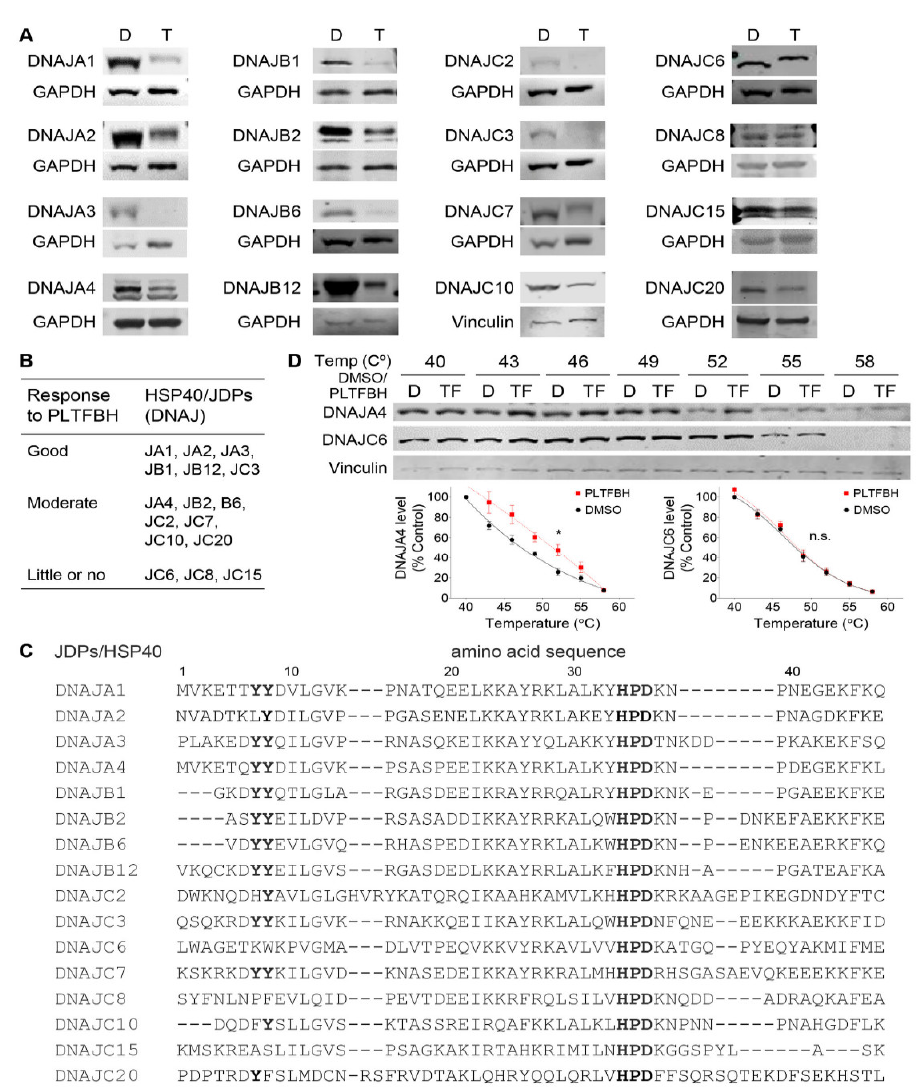
Figure 5. PLTFBH selectively decreases protein levels of certain members of HSP40/JDPs. ( A ) Western blotting for several members of HSP40/JDPs and GAPDH using HN31 cells treated with DMSO (D) or PLFBH (TF) at ~1/2 IC50 for 24 h. ( B ) Three groups (good, moderate, little or no) of HSP40/JDPs based on their response to PLTFBH. Note that some blots were from the same membrane (DNAJB1 and DNAJB2; DNAJB6 and DNAJC6; DNAJC2 and DNAJC3), hence using the same GAPDH control. ( C ) Amino acid sequence alignment of the J domain of multiple HSP40/JDPs by centering the HPD sequence. ( D ) CETSA showing intracellular binding of PLTFBH with DNAJA4, but not DNAJC6, in CAL33 cells treated with 80 µ M of PLTFBH (TF) for 4 h. Vinculin was used as a loading control. Summarized graphs showing normalized DNAJA4 and DNAJC6 band densities at different temperatures ( right ). Mean ± SEM from three independent experiments ( n = 3). * p < 0.05 for two-way